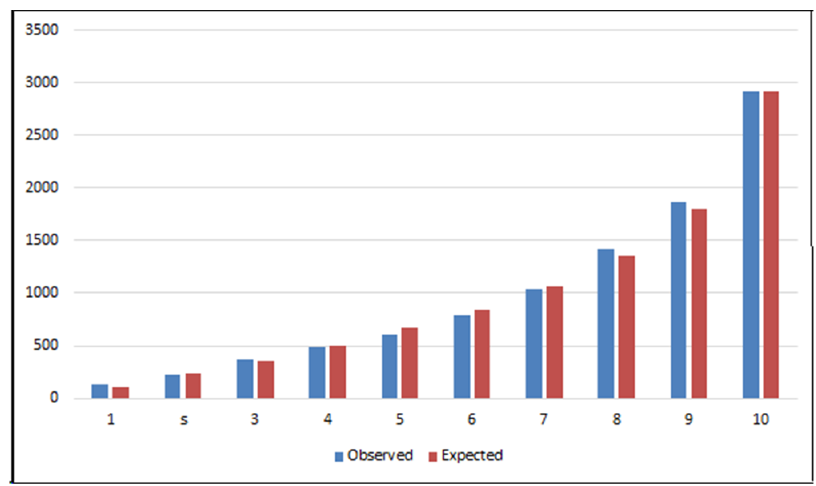
Figure 4. Graphical representation of the risk deciles by the Hosmer–Lemeshow test. Hosmer– Lemeshow test values: χ 2 = 26.094, p = 0.01.